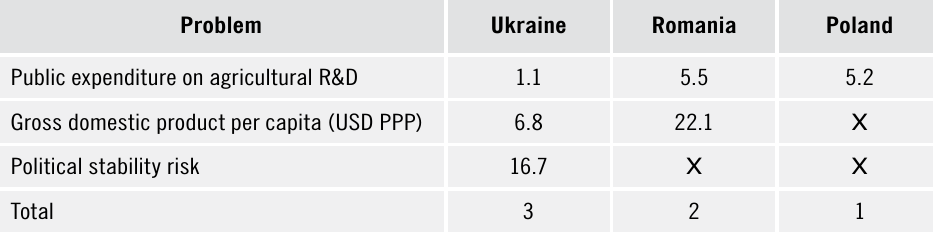
Table 2. Food security problems by country, 2019